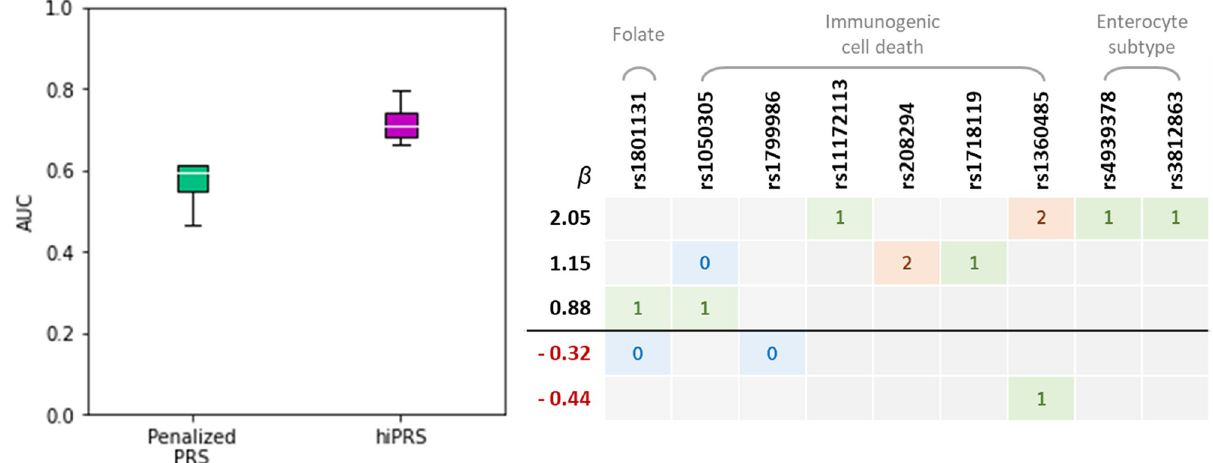
Fig 8. DACHS case study results. Left panel: AUCs obtained by hi PRS and a benchmark model during cross-validation (four folds). Average AUCs are 0.72 and 0.57 respectively for hi PRS and the benchmark model. Right panel: interactions selected by hi PRS, and corresponding effect-sizes, when fitting the model on the whole dataset. In grey are reported the pathways each SNP belongs to (cf. Materials and methods).